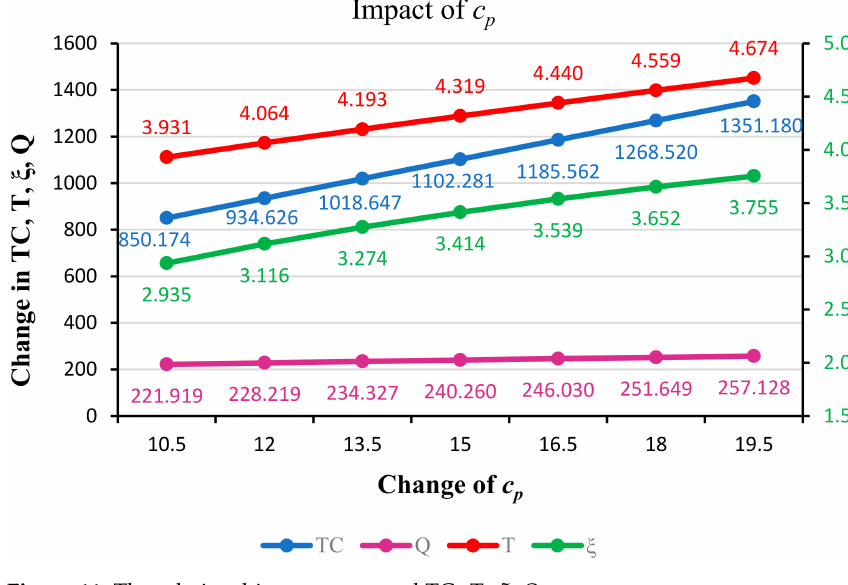
Figure 11. The relationship among c p and TC, T, ξ , Q .